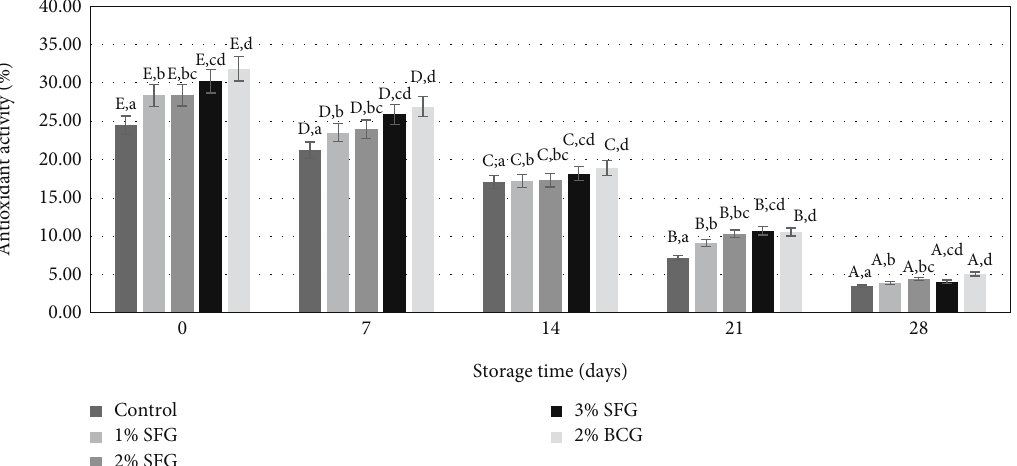
Figure 4: Addition of gelatin level and storage time on antioxidant activity (%) sausage. Di ff erent uppercase letters indicate di ff erences in storage time ( p < 0 : 05 ), and lowercase letters indicate di ff erences with level gelatin ( p < 0 : 05